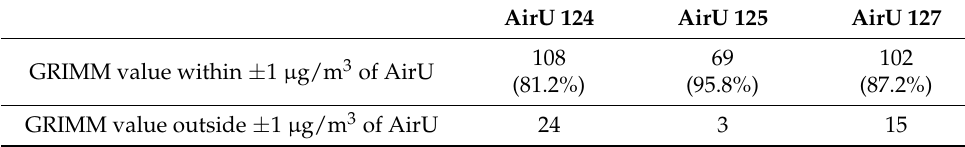
Figure 3. Time Series depicting daily average PM counts (in µg/m 3 ) for AirU/Grimm comparison. Table 3. The GRIMM analyzed against the AirUs for a − 1 µ g/m 3 and +1 µ g/m 3 change in con- centration measurement. This chart shows the number of observations in which the AirU and the GRIMM